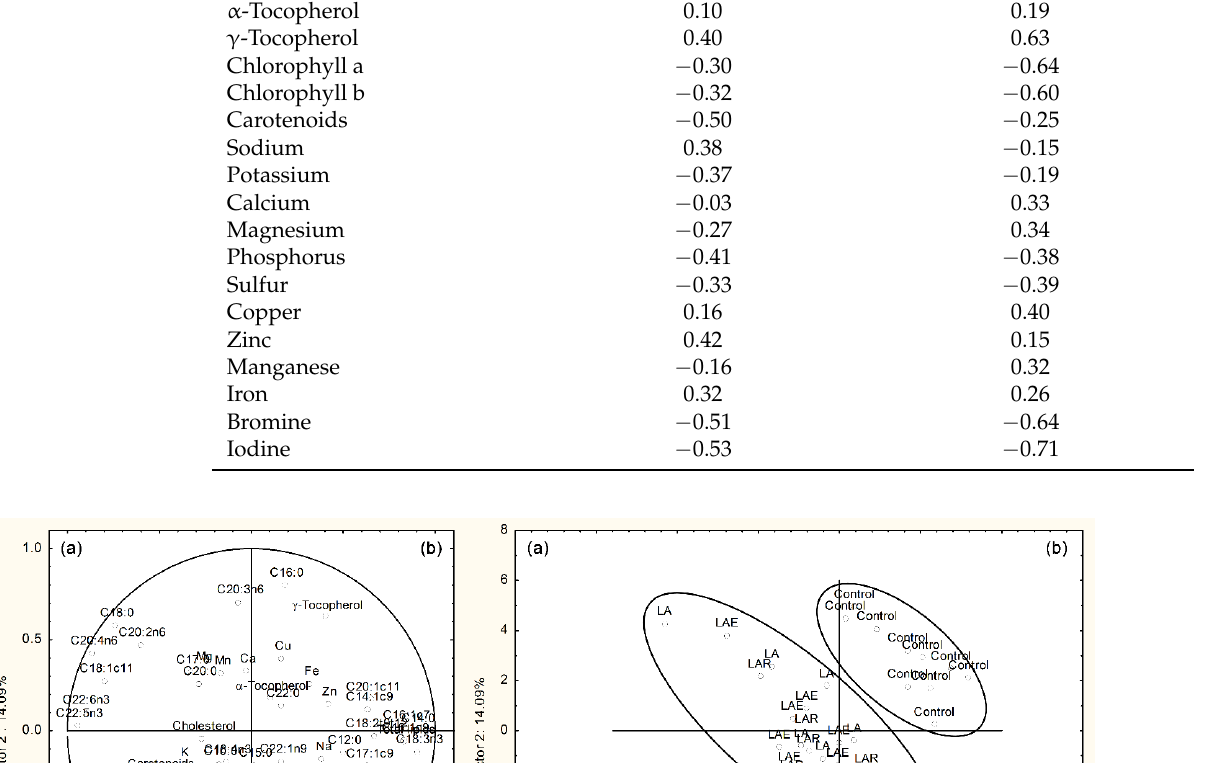
significant difference ( p < 0.05).